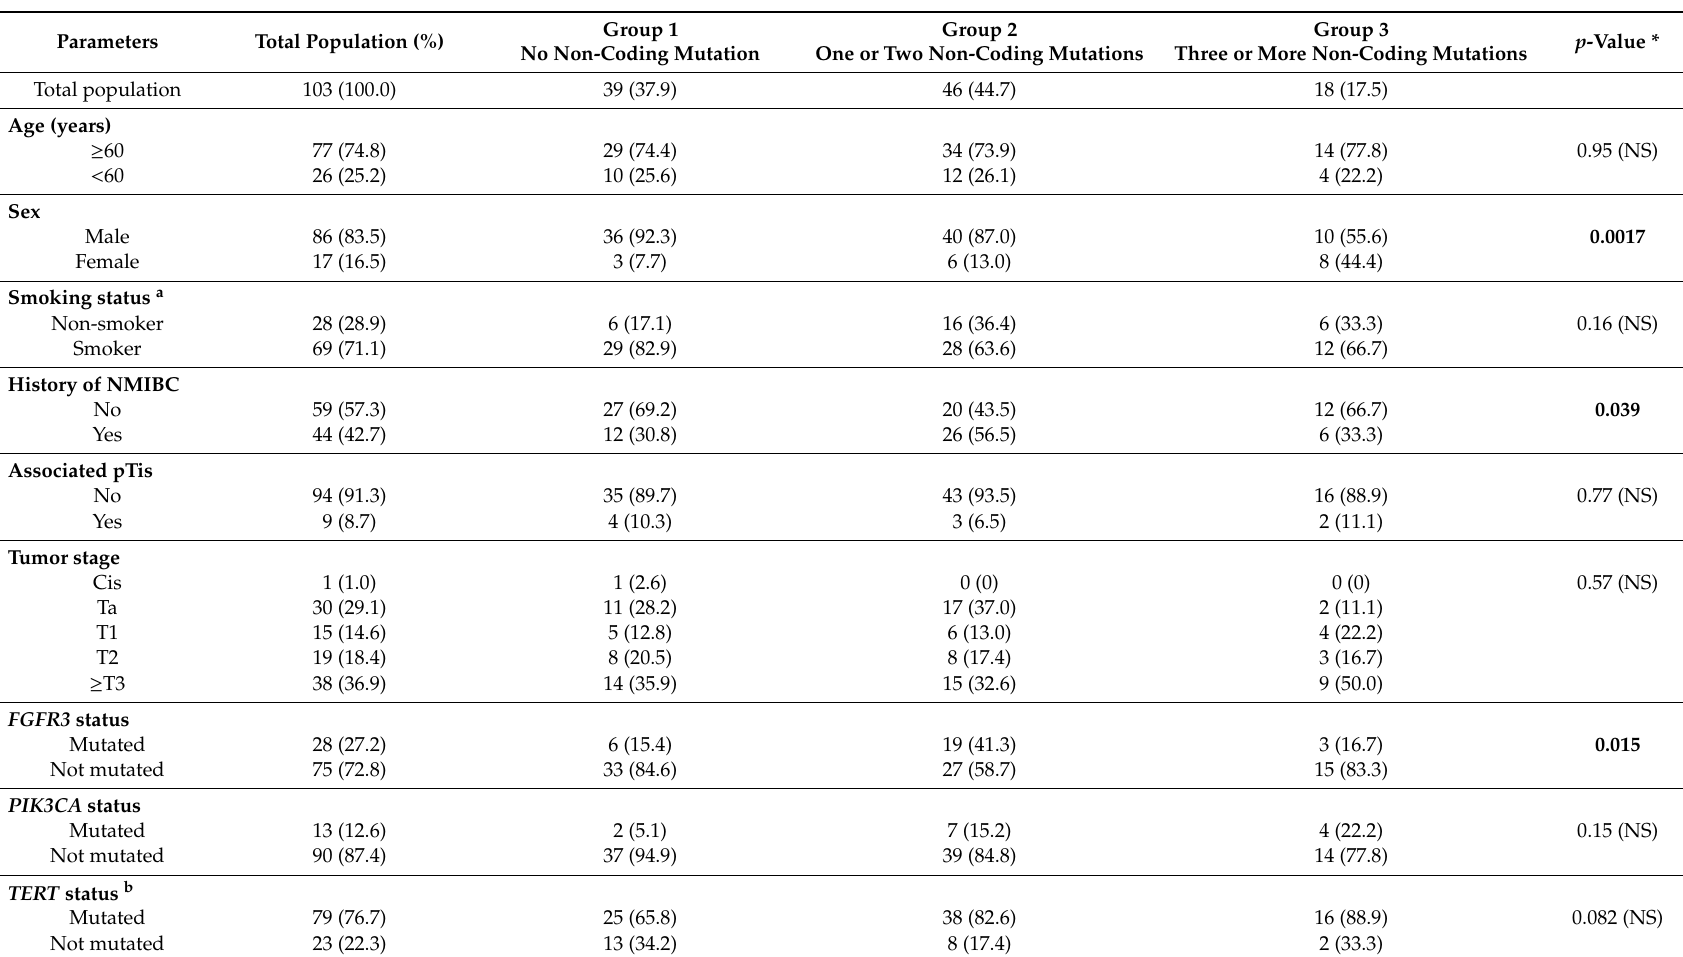
Table 5. Relationship between TGAACA core motif mutational signature and standard clinical pathological and biological